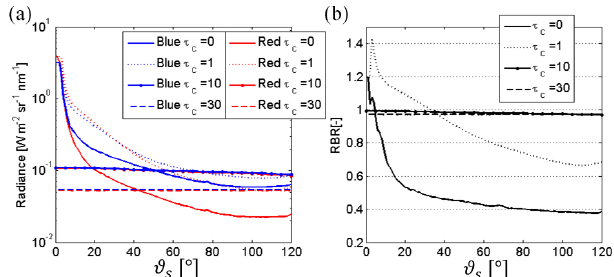
Figure 6. (a) SHDOM red and blue channel radiance over various sun pixel angles ( ϑ s ) at ϑ z = 60 ◦ , and θ 0 = 60 ◦ (pixels used for Fig. 6 are highlighted as a red line in Fig. 3c). Results are shown for different cloud optical depths from clear ( τ c = 0) to thick clouds. (b) RBR as a function of ϑ s at constant ϑ z = 60 ◦ and θ 0 = 60 ◦ .